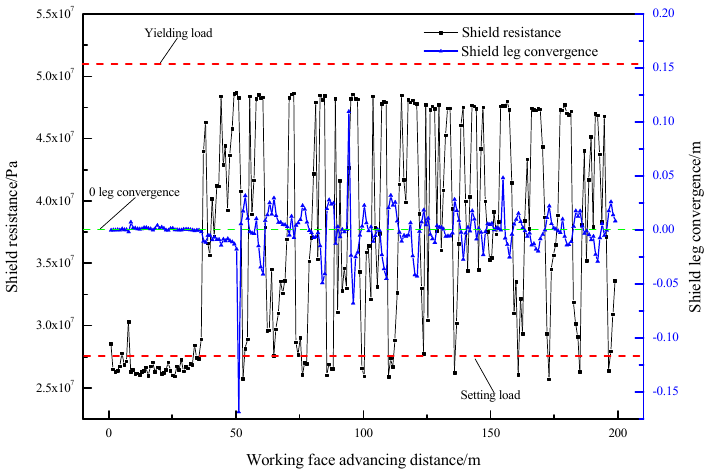
periodic weighting interval was about 11.0 m.